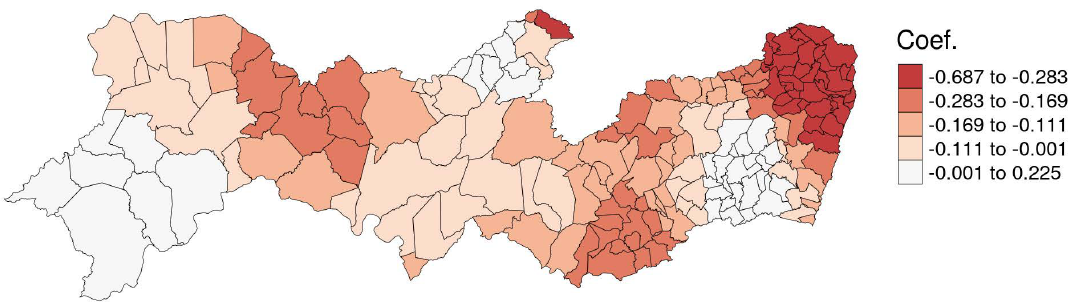
Figure 8. Distribution of the local coe ffi cients of the GWR model (Theil-L Index).